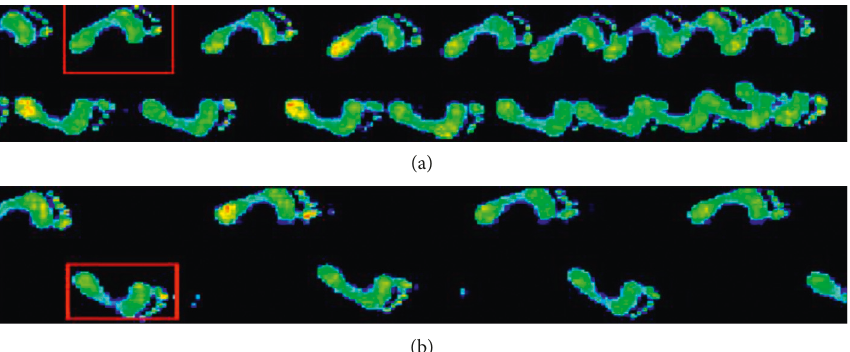
Figure 4: Example of the cadence measured during walking without (a) and with (b) using cues in a patient with Parkinson’s disease. These figures were produced using 2-metre RS foot